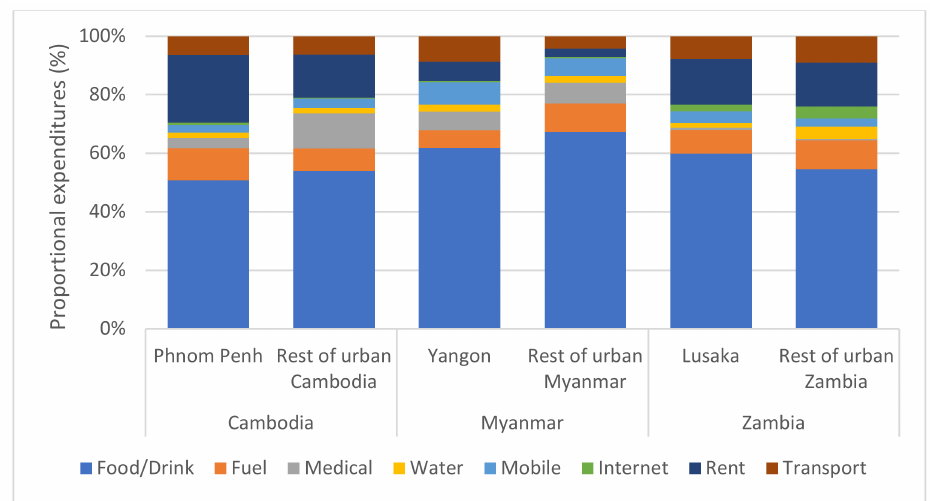
Figure 2. Proportional monthly expenditures for households stacking biomass with modern fuels for